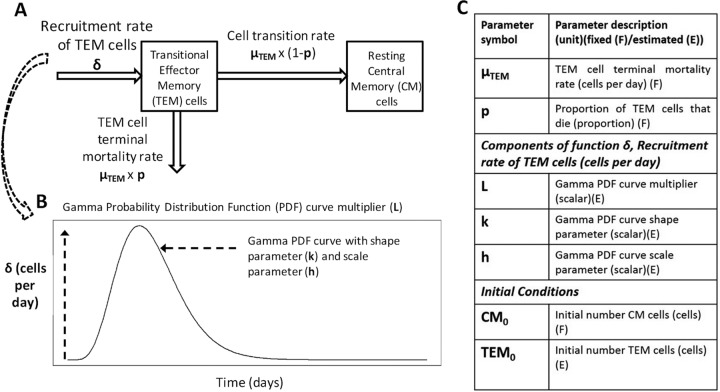
(A) Schematic of the mathematical model representing the immune response dynamics of two CD4+ T cell populations secreting IFN-γ. (B) Depiction of the changes in the recruitment rate of transitional effector memory cells (δ) over time. (C) Key model parameters. Equations may be found in the supplemental material.